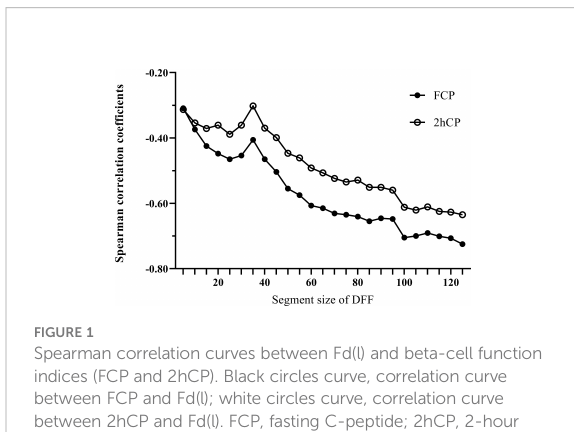
FIGURE 1 Spearman correlation curves between Fd(l) and beta-cell function indices (FCP and 2hCP). Black circles curve, correlation curve between FCP and Fd(l); white circles curve, correlation curve